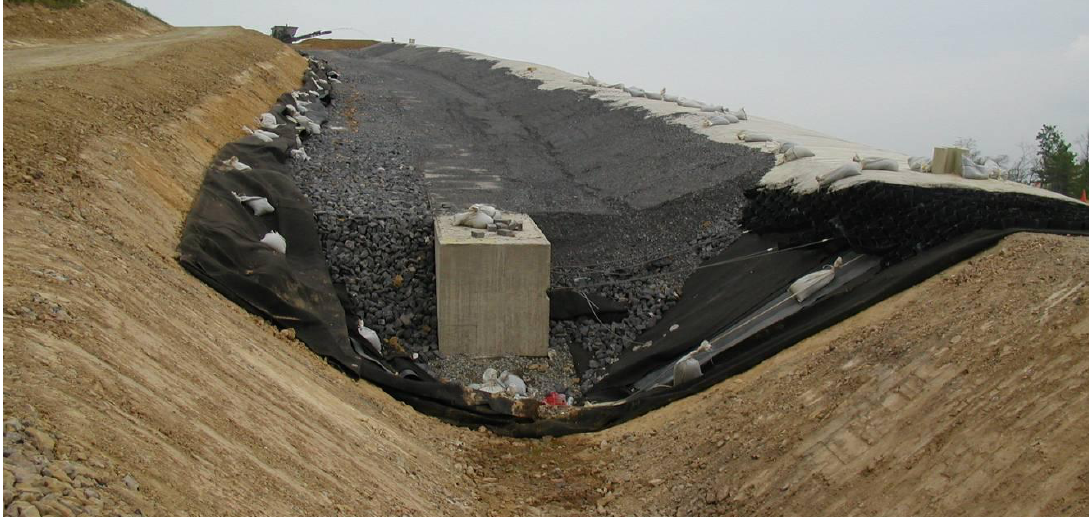
Figure 14. Photo showing cross section of concrete deadman anchor